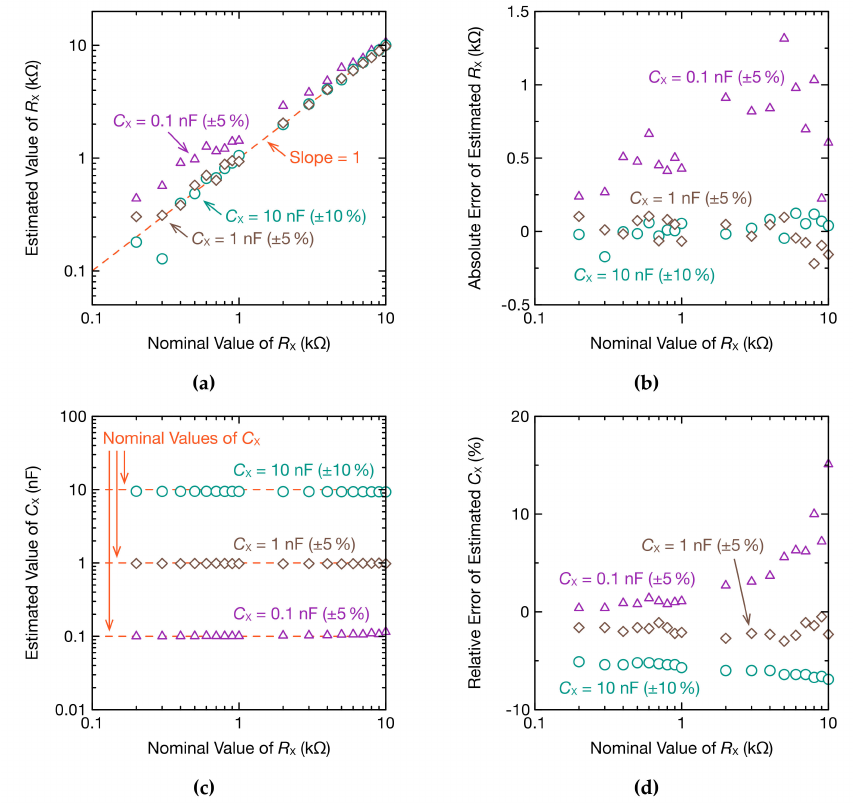
Figure 8. R X and C X estimated using oscillation waveforms and DFT: ( a ) estimated R X ; ( b ) absolute error of estimated R X ; ( c ) estimated C X ; ( d ) relative error of estimated C X